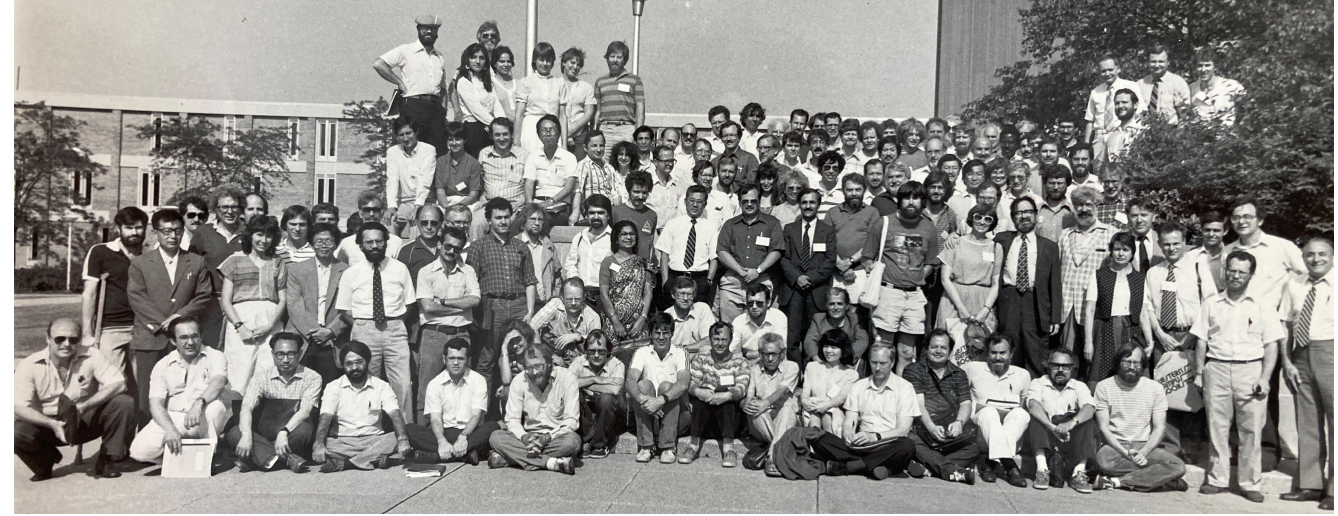
Figure 3: Fifth International Conference on the Theory and Applications of Graphs,